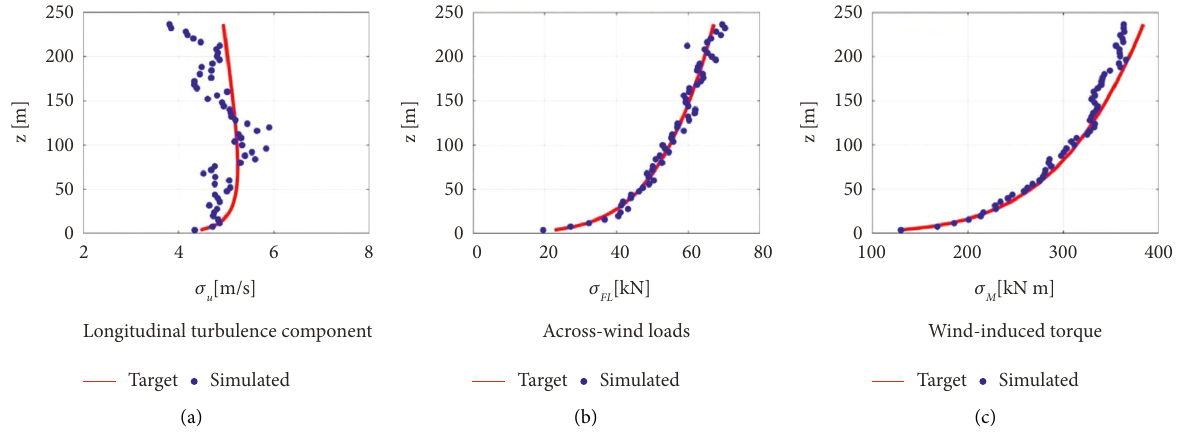
Figure 17: Standard deviations along the height H/sqrt(BD) � 8.